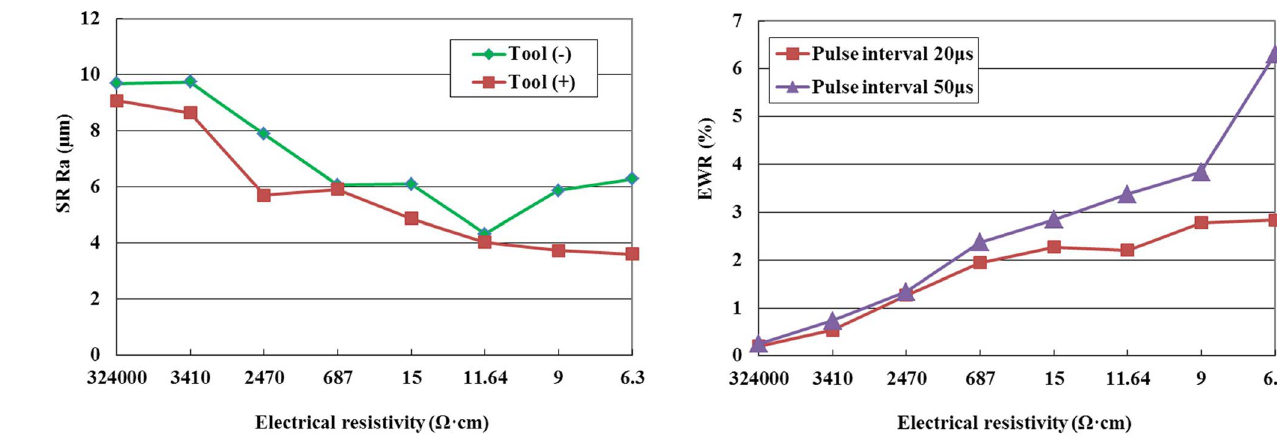
Figure 9. Effect of the pulse interval on EWR.